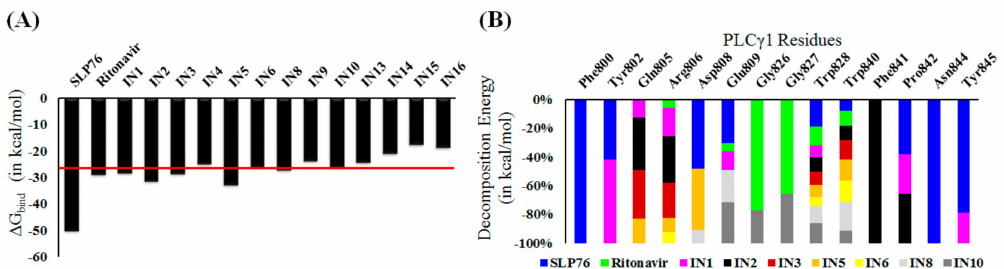
Figure 4. Interaction analysis for the molecular dynamics of the sixteen complexes. ( A ) Average ∆ G bind value calculated over the last 5 ns. Red line indicates the cuto ff used for final selection of compounds and ( B ) Per-residue decomposition energy analysis for selected potential PLG γ 1-inhibtior complexes during molecular dynamics (MD)